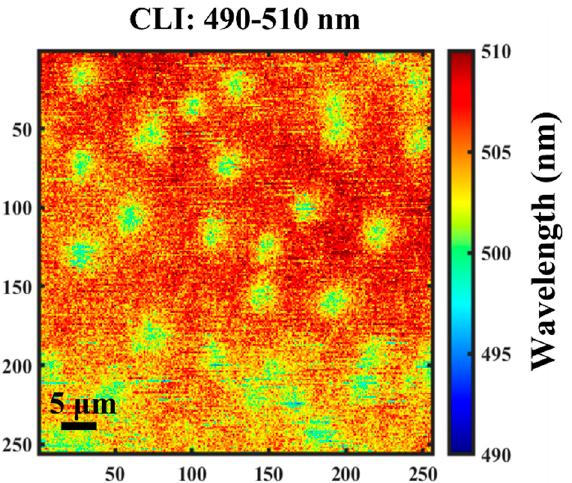
Figure 6. Two-dimensional mapping of full-composition-graded In x Ga 1 − x N film under 15 kV excita- tion voltage with the wavelength range from 490 nm to 510 nm at room temperature.